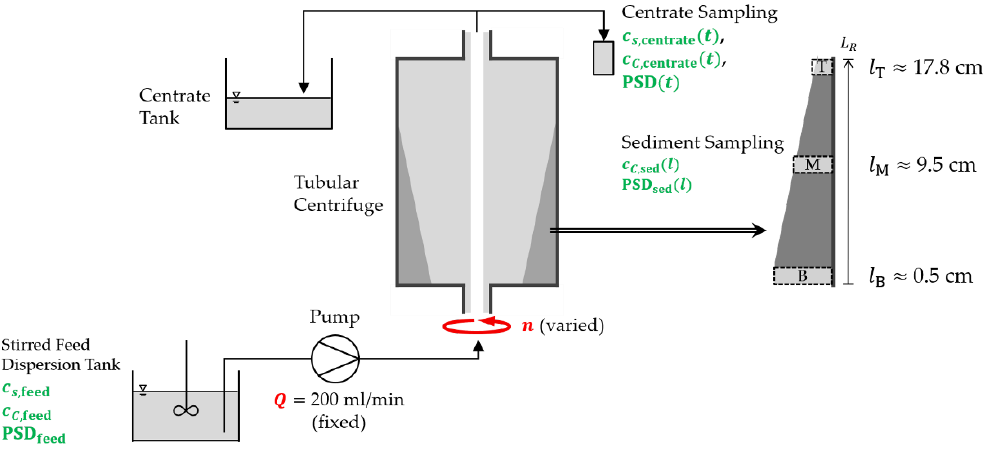
Figure 4. Outline of the experimental set-up with components (black/grey), operational parameters ( red ) and sampling locations with properties analyzed ( green ).